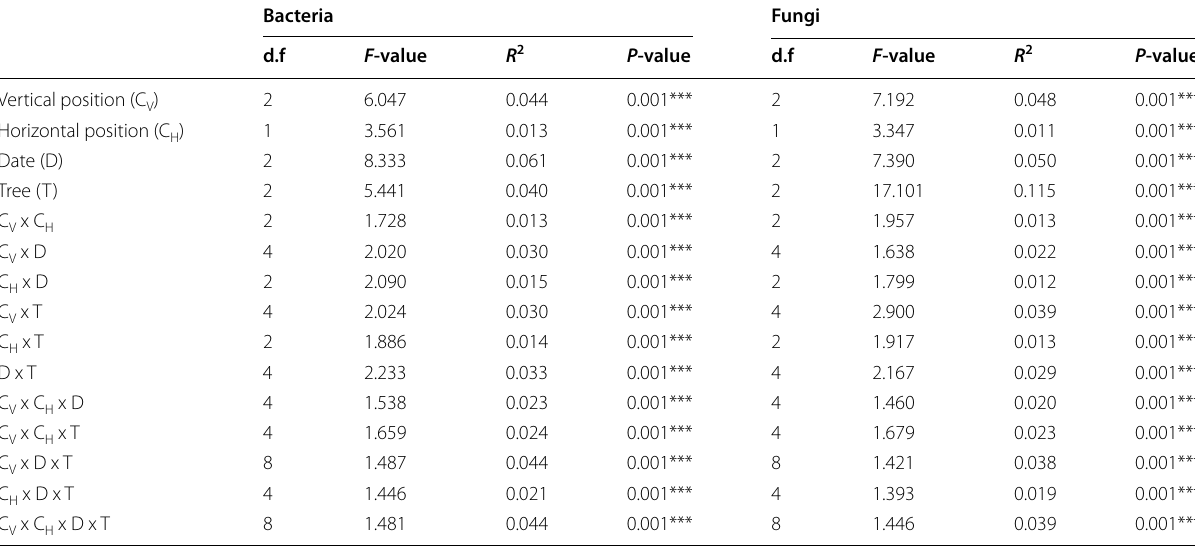
Table 3 Effect of within-canopy leaf position on the composition of phyllosphere microbial communities of European beech ( Fagus sylvatica ), tested using permutational multivariate analyses of variance (PERMANOVA). Compositional dissimilarities among leaves were estimated using the binary version of Jaccard distance. The effects of sampling date ( D ), tree identity ( T ), within-canopy vertical position ( C ), and horizontal position ( C ) and their interaction were tested using sample Set#1(Fig. 1C) V H